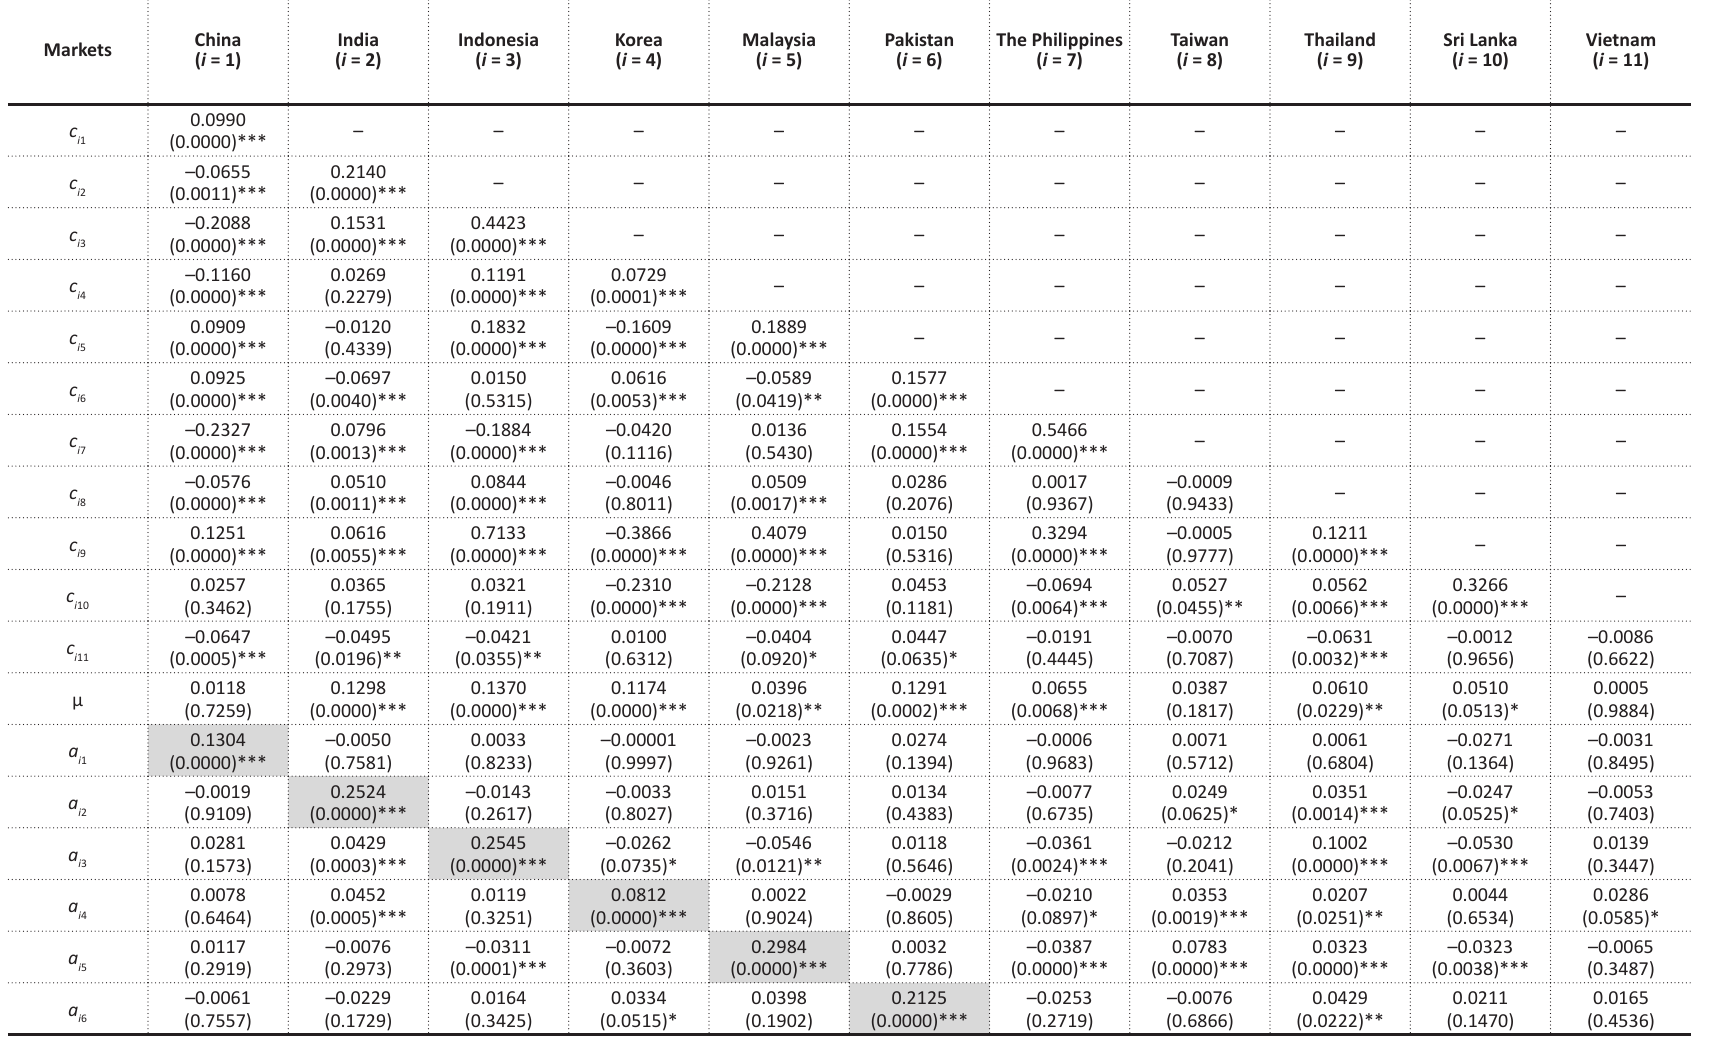
Table 4. Shocks and volatility spillover between stock markets during pre-global financial crisis